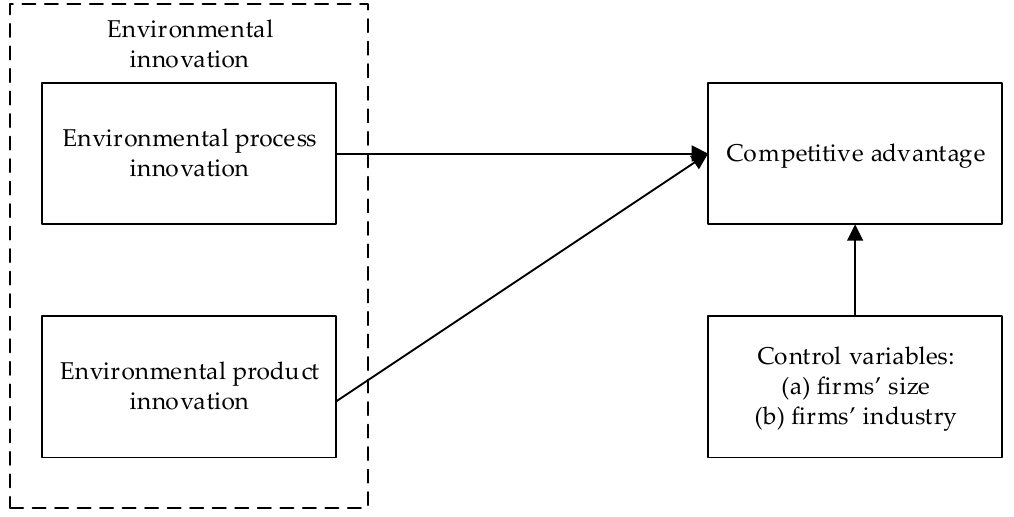
Figure 1. Research framework.